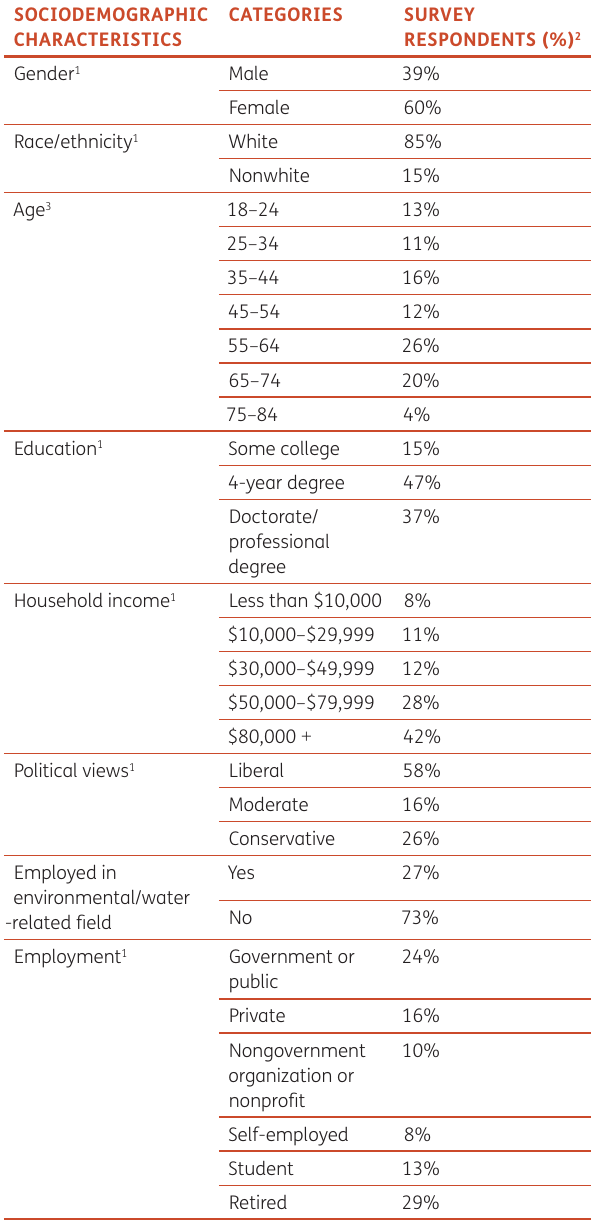
Table 1 Sociodemographic characteristics of survey